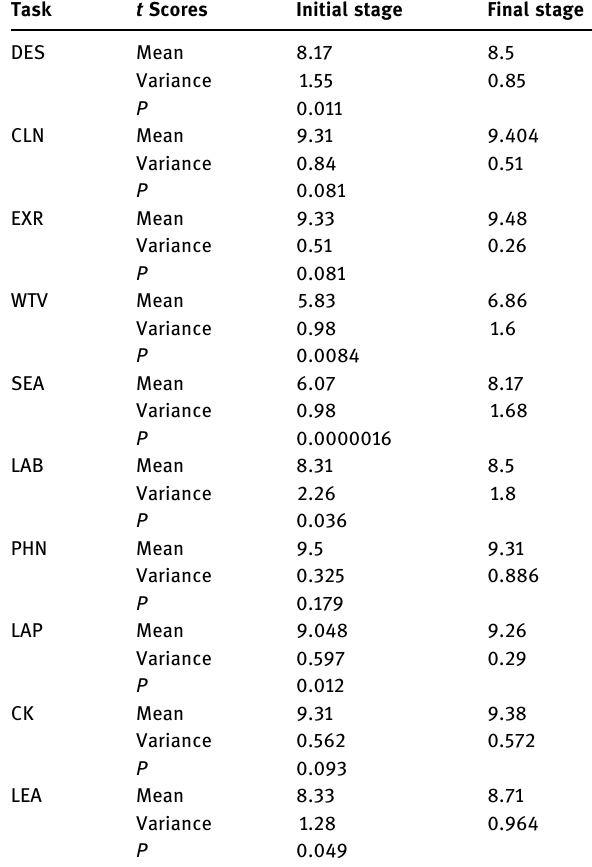
Table 3: t test for the comparison of user feedback scores in initial and fi nal attempts